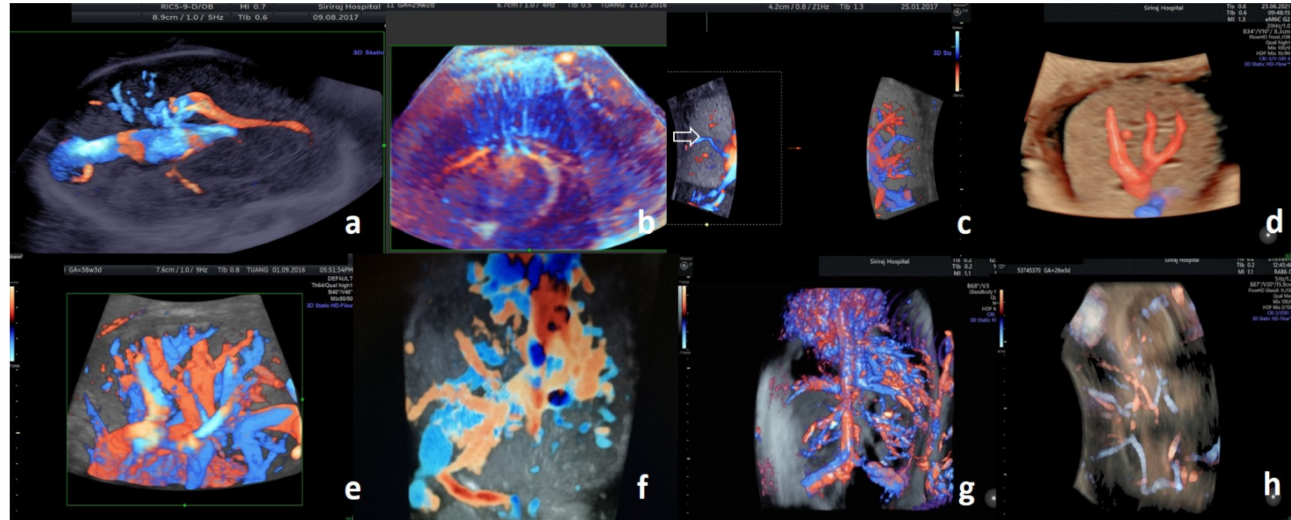
Figure 1. Fetal assessment with three-dimensional sonoangiography. ( a ) Vein of Galen aneurysmal malformation of a fetus at 30 weeks of gestation; thick-slice, three-dimensional, high-definition flow (3D HDF). ( b ) Deep medullary veins of a fetus at 29 weeks of gestation; thick-slice 3D HDF. ( c ) Diminished vasculatures (arrow) of right lung with primary dysplasia, compared with the left normal lung, in left and right lung of a fetus at 29 weeks of gestation; thick-slice 3D HDF. ( d ) Primitive hepatic vasculature of a fetus at 22 weeks of gestation; HDLive Silhouette (GE, Milwaukee, WI, USA), thick-slice 3D HDF. ( e ) Mature hepatic vasculatures of a fetus at 38 weeks of gestation; thick-slice 3D HDF. ( f ) Confluent vasculatures of hepatic hemangioma of a fetus at 30 weeks of gestation; thick-slice 3D HDF. ( g ) Complex visceral vasculatures of a fetus at 20 weeks of gestation; thick-slice 3D HDF. ( h ) Primitive visceral vasculatures of an acardia at 26 weeks of gestation; HDLive Silhouette (GE, Milwaukee, WI, USA), thick-slice, 3D